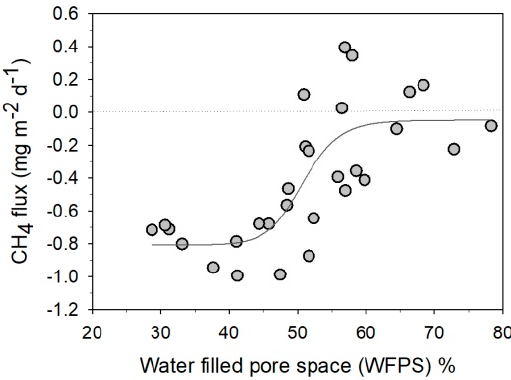
Figure 3. Upland site, average ( n = 8) daily CH 4 fluxes plotted vs. soil water-filled pore space (%) estimated from volumetric water content measured inside the chambers at the end of gas sampling. Equation of the fitting curve: y = − 0.81 + 0.76/[1 + (x/ − 50.78) − 19.23 ], R 2 = 0.58, p < 0.0001.